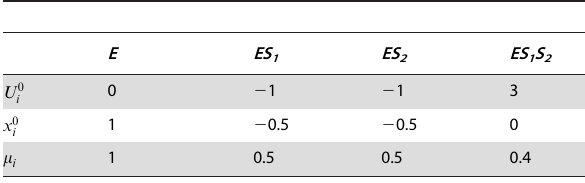
Table 1. Model parameters for enzyme states for the reaction scheme in Fig. 1b.